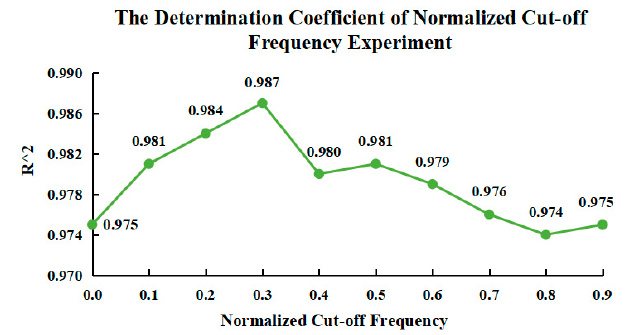
Figure 11. MRA of the results for various normalized cut-off frequencies.